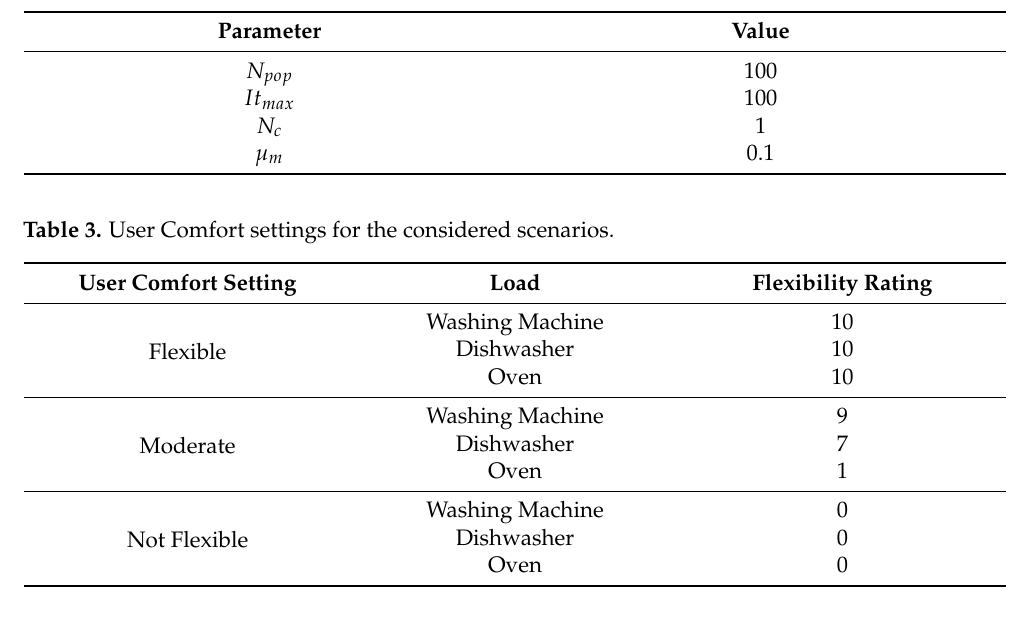
Table 2. Parameters of the genetic algorithm in the simulation.